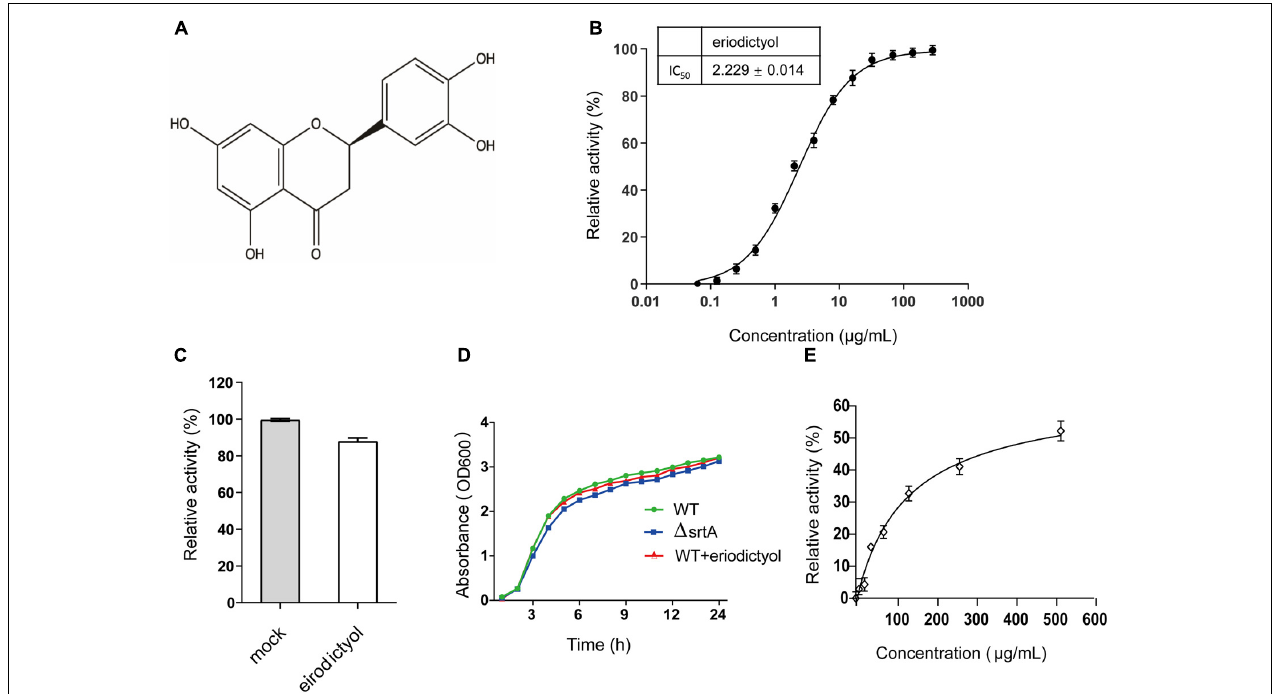
FIGURE 1 | Eriodictyol acts as a reversible inhibitor of SrtA. (A) Chemical structure of eriodictyol. (B) Eriodictyol inhibited the cleavage of the Abz-LPATG-Dap (Dnp)-NH 2 substrate by SrtA in a dose-dependent manner. Each reaction condition was assayed in triplicate, and the data are presented as the mean ± SEM. (C) SrtA was treated with or without 10 × IC 50 of eriodictyol and then diluted; the SrtA activity was subsequently determined by FRET assay. Untreated SrtA (mock) was assumed as 100% activity. (D) Growth curves of S. aureus USA 300 and the (cid:49) srtA mutant strains with or without eriodictyol (128 µ g/mL). (E) Percentage of viability of Vero cells was measured by the CCK-8 assay after 24 h of incubation with eriodictyol (0–512 µ g/mL).